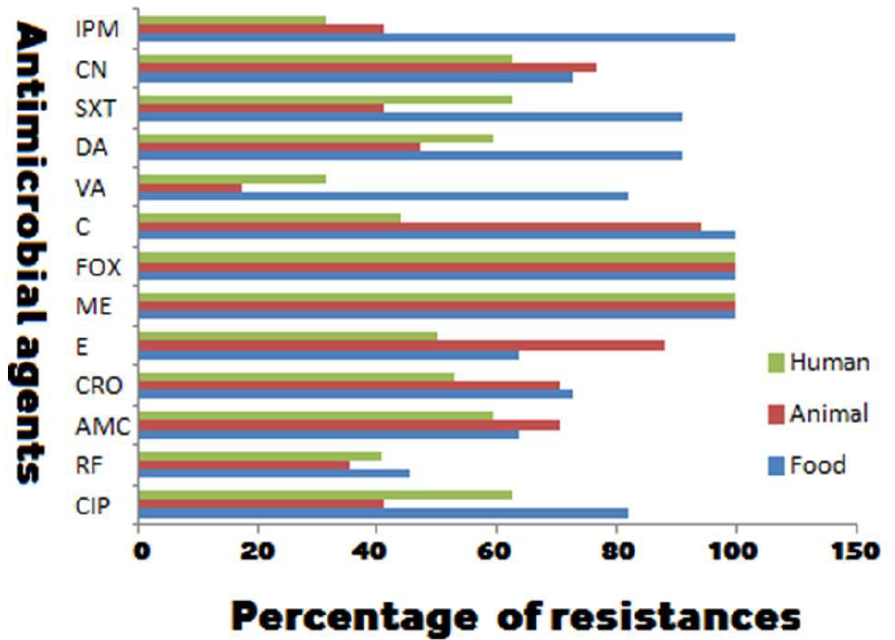
Figure 1. Antimicrobial resistance of biofilm producing methicillin-resistant Staphylococcus aureus